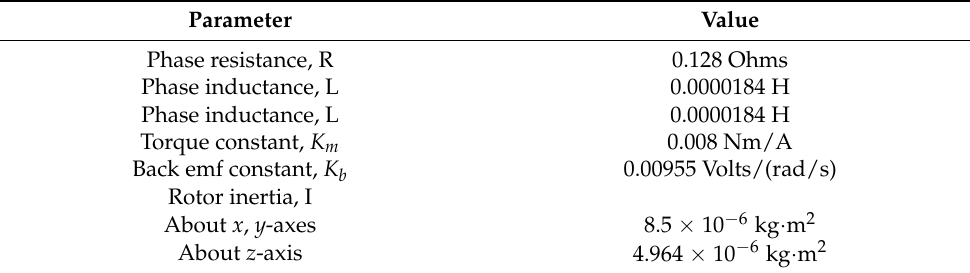
Table 1. 1000 KV Brushless DC motor specifications.